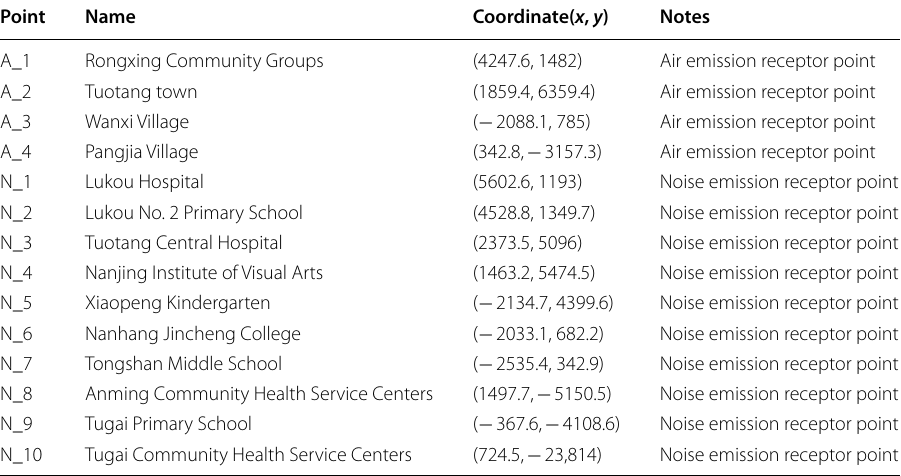
Table 2 The information of air and noise emission receptor points Point